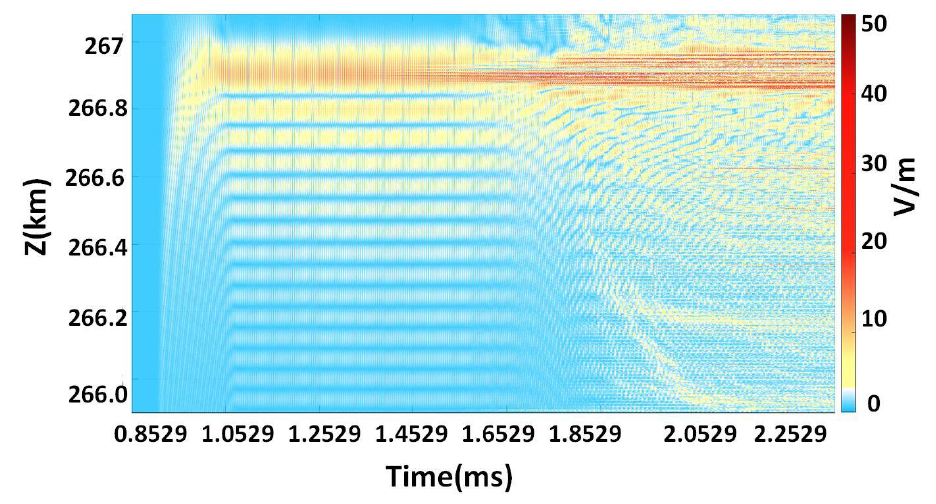
Figure 7. Variation in the electric field | E z | with